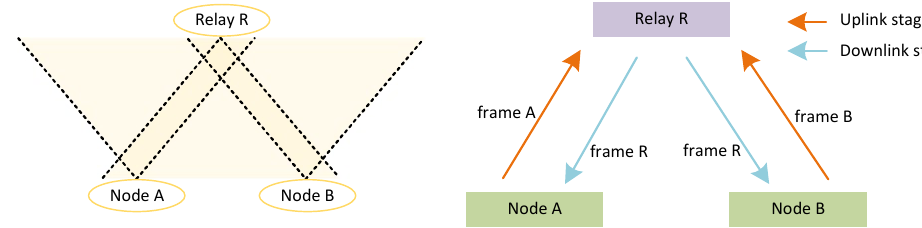
Figure 1. VLC system in TWRC under a PNC scheme.